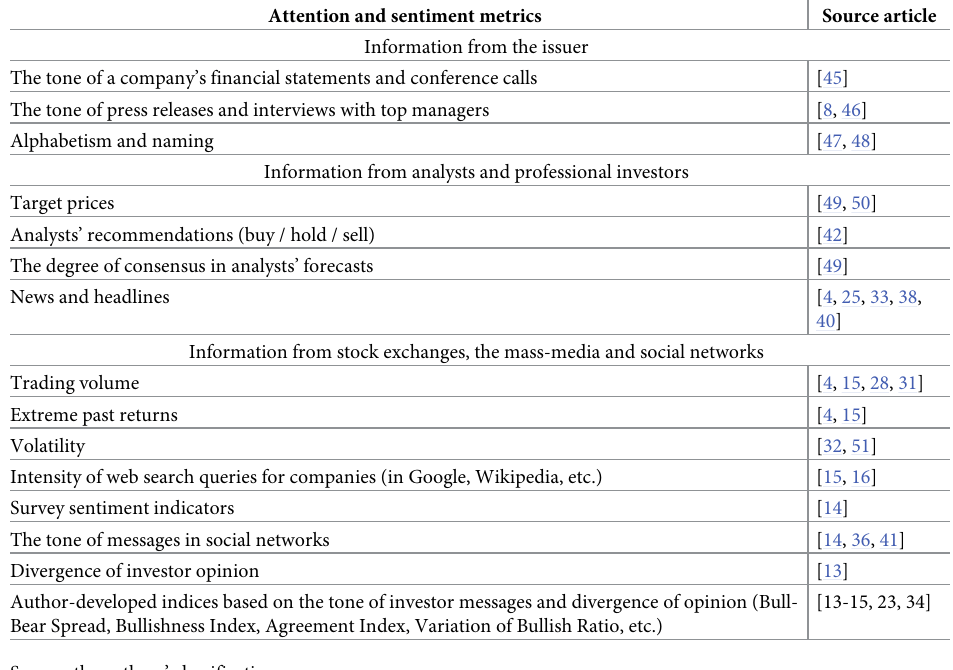
Table 1. Summary of attention and sentiment metrics from the review of previous research.